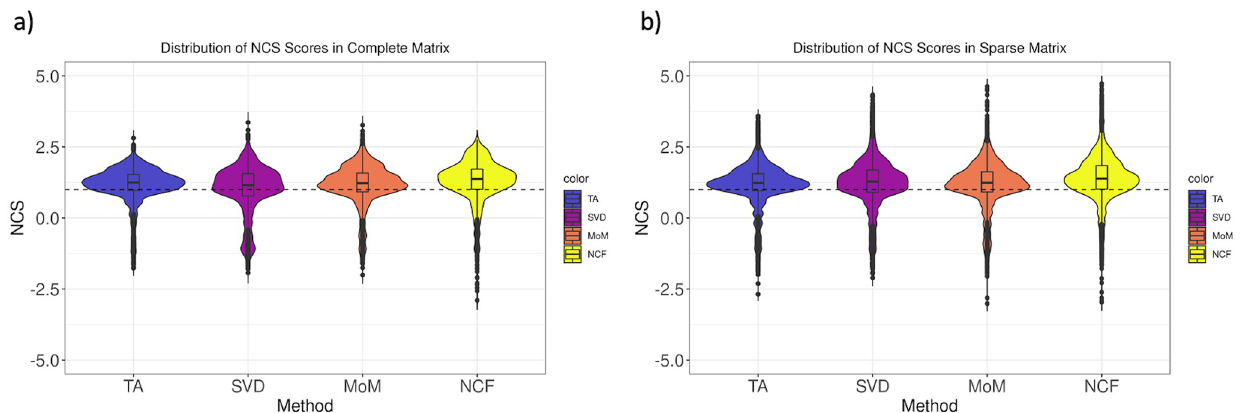
Fig 5. Distribution of connectivity scores for related drugs with imputed data. a) Violin plot showing distribution of normalized connectivity scores of drugs from a given drug set imputed from the complete matrix. b) Violin plot showing distribution of normalized connectivity scores of drugs from a given drug set imputed from the sparse matrix. Dashed lines show an NCS of 1.0. Abbreviations: NCS: Normalized Connectivity Score for drug-set enrichment analysis as defined in section 2.5.1; TA: Tissue-Agnostic; NCF: Neighborhood Collaborative Filtering.